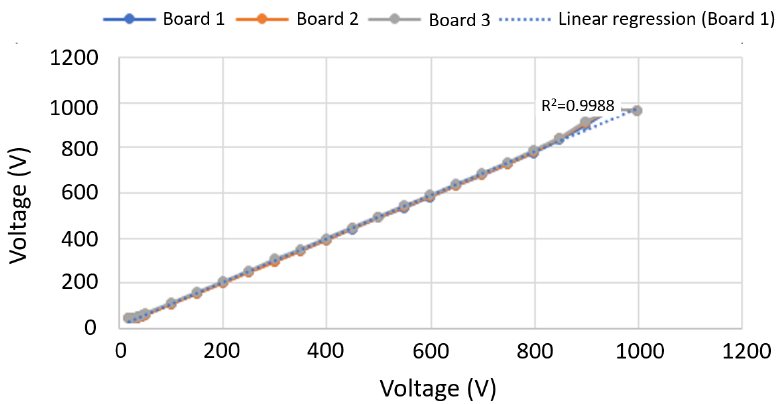
Figure 5. Voltage sensor calibration process: comparison of input voltage vs measured voltage.